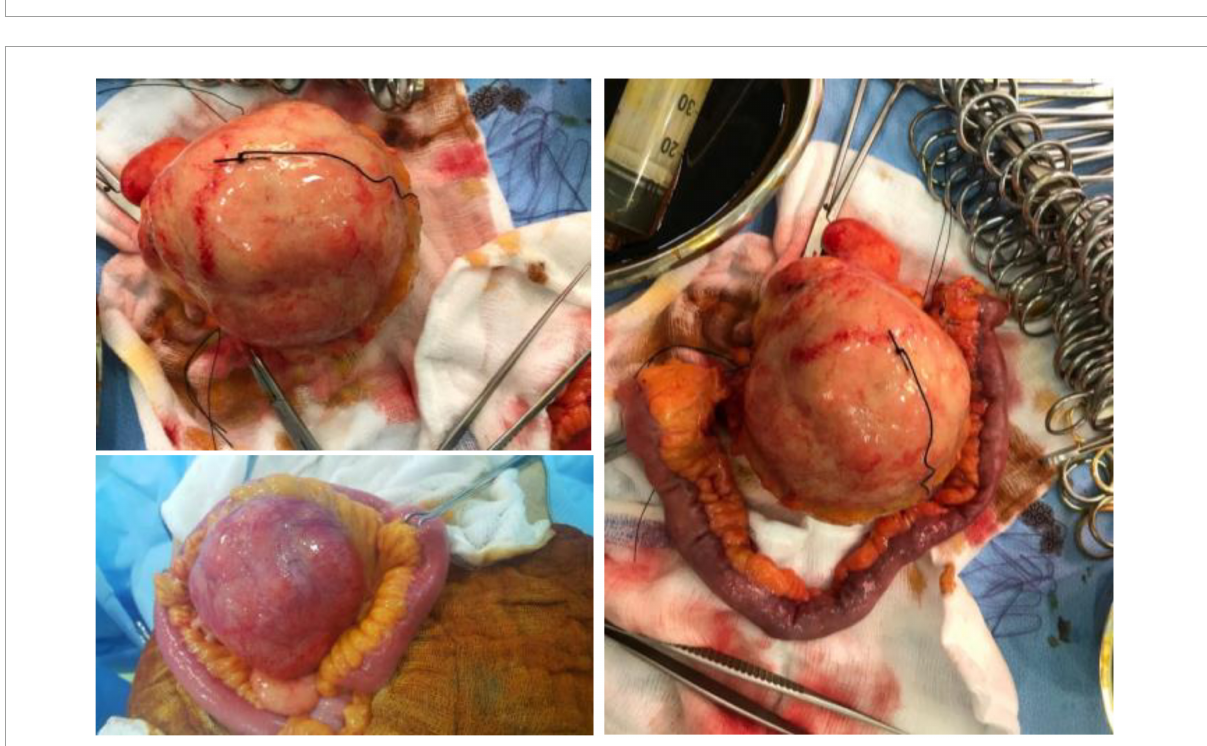
FIGURE2 Gross image of the tumor with associated bowel